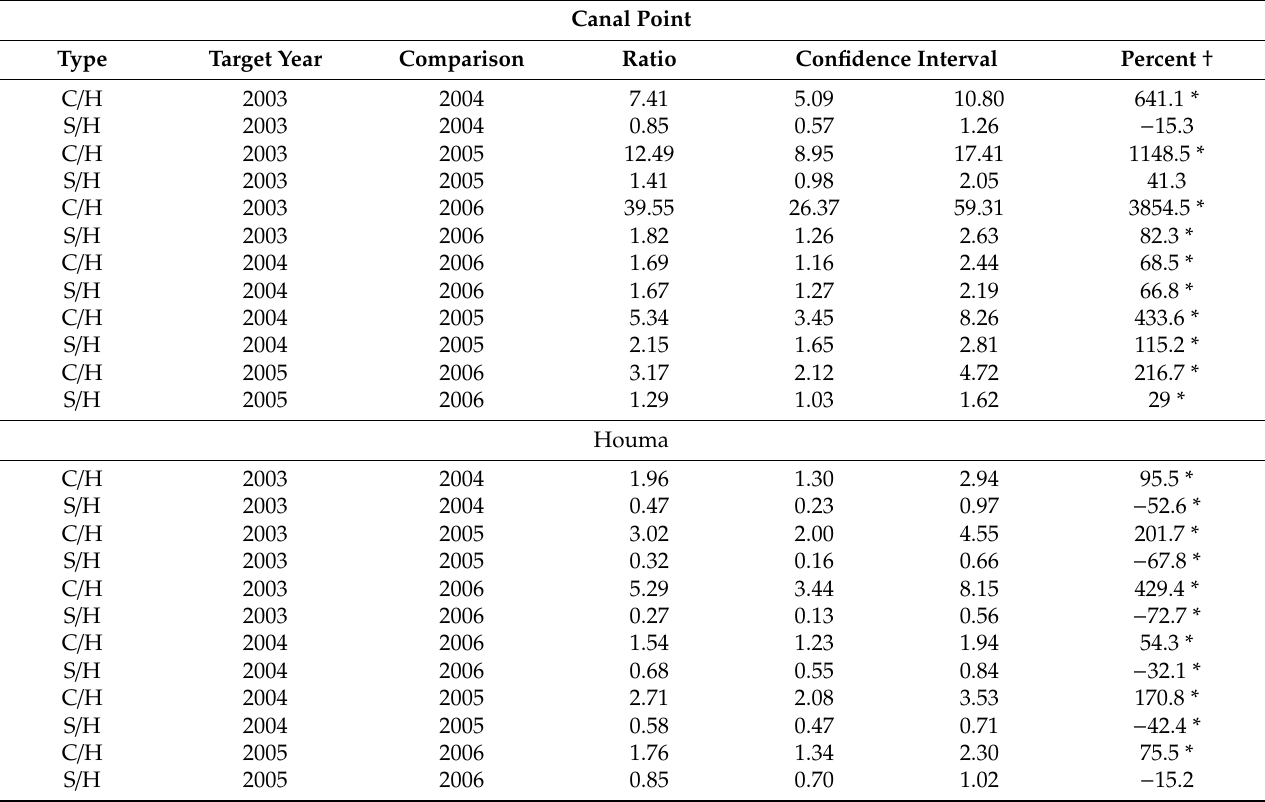
Table 5. Odds ratio estimates for crosses made at Canal Point, FL; Houma, LA; and St. Gabriel, LA (LSU) in 2003–2006. Parental status including intentional hybridization (H), selfing (S), or unintentional outcross (C) was identified from a random sample of 20 from each cross. The ratio of o ff -types and selfing to hybrids was compared between years, so increases or decreases in the percentage of selfs or outcrossed progenies can be identified from the target